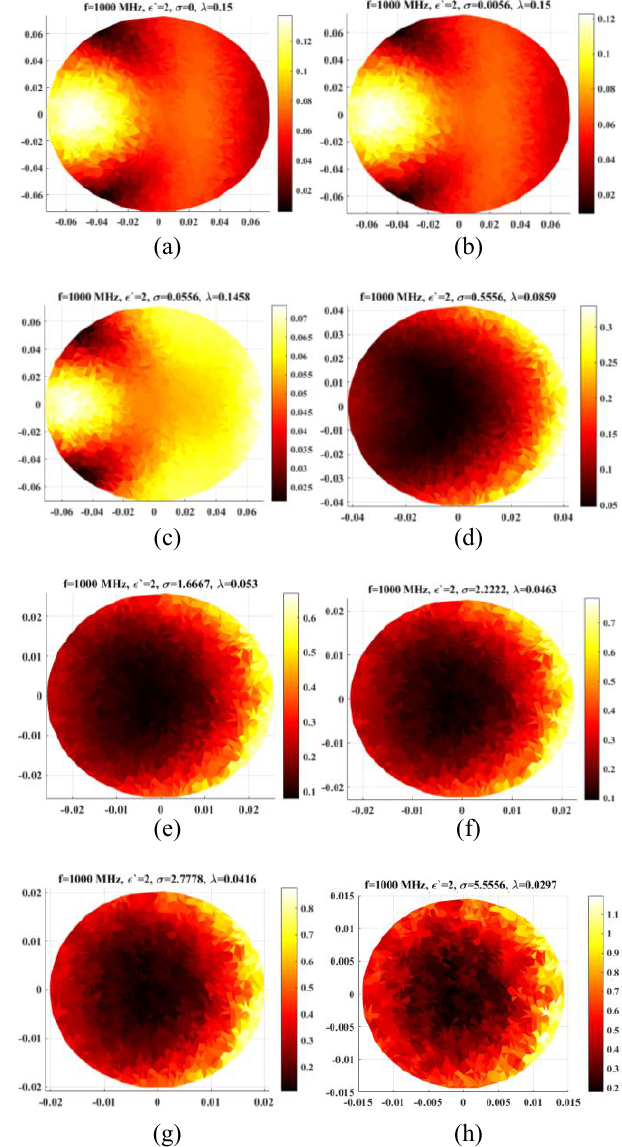
Figure 5: Field distribution as 𝜎 increases (a) 𝜎 =0, (b) 𝜎 =0.0056, (c) 𝜎 =0.0556, (d) 𝜎 =0.5556, (e) 𝜎 =1.6667, (f) 𝜎 =2.2222, (g) 𝜎 =2.7778, (h) 𝜎